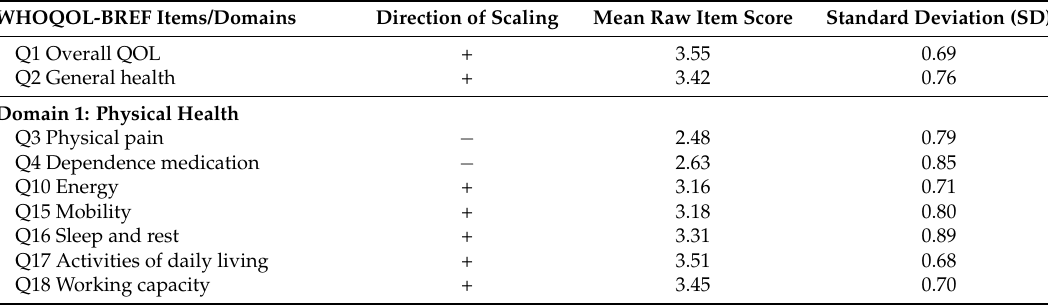
Table 3. Scores of WHOQOL-BREF items among the elderly Chinese ( n = 1168). WHOQOL-BREF Items/Domains Mean Raw Item